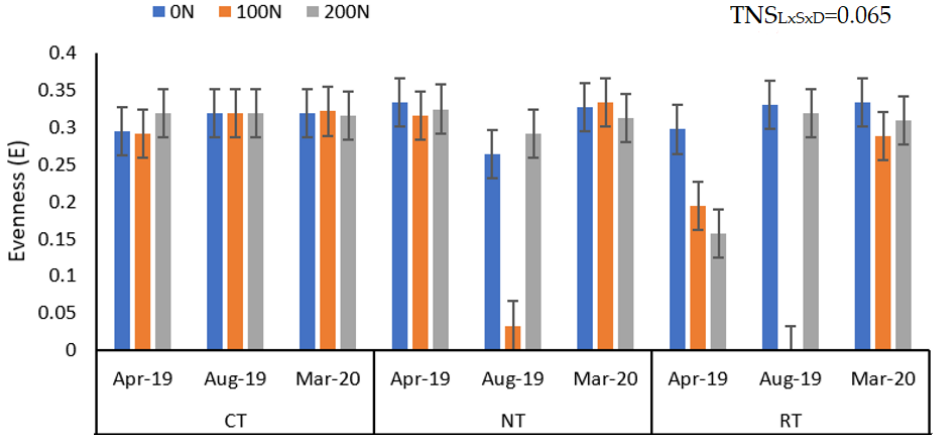
Figure 9. Variation in the Evenness index of soil macrofauna communities in different tillage treatments, N fertiliser application rates, and sampling times. April-19 = April 2019, Aug-19 = August 2019 and Mar-20 = March 2020. T = treatments, N = nitrogen fertiliser application rate and S = sampling time.